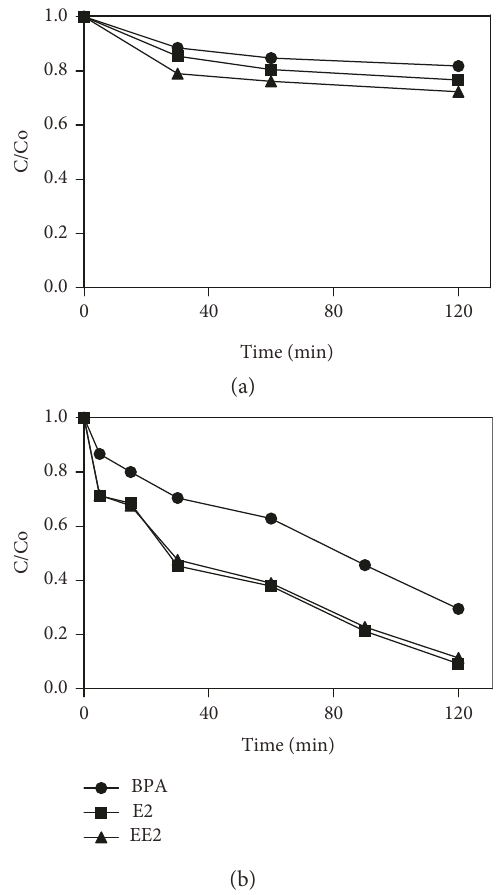
Figure 1: EDC degradation by photolysis in ultrapure water: (a) UVA; (b) UVC; initial EDC concentrations: 100 μ g · L -1 , UVC =14.79mW cm -2 , UVA =6.80mW cm -2 , T =25 ° C, pH =7, reaction time